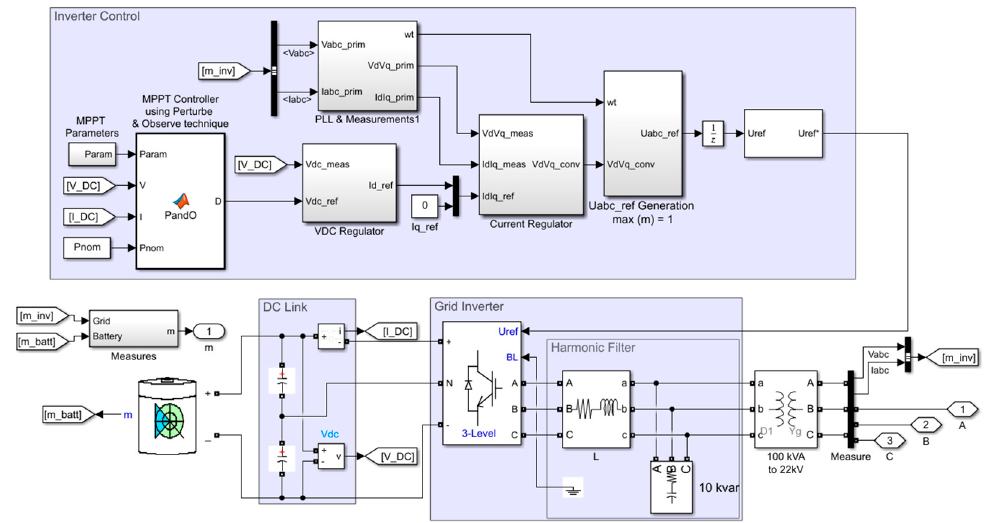
Figure 10. Schematic model of battery energy storage system.